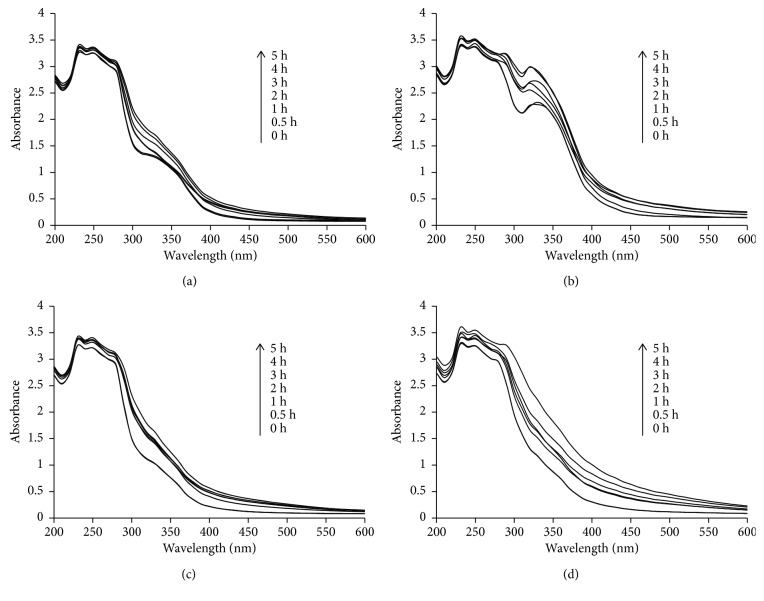
UV-visible spectra of CuNPs synthesized by plant extracts using 10−3 M aqueous CuSO4·5H2O solution in the dark at 100°C: (a) GGFE, (b) GGLE, (c) GGSE, and (d) PZLE.